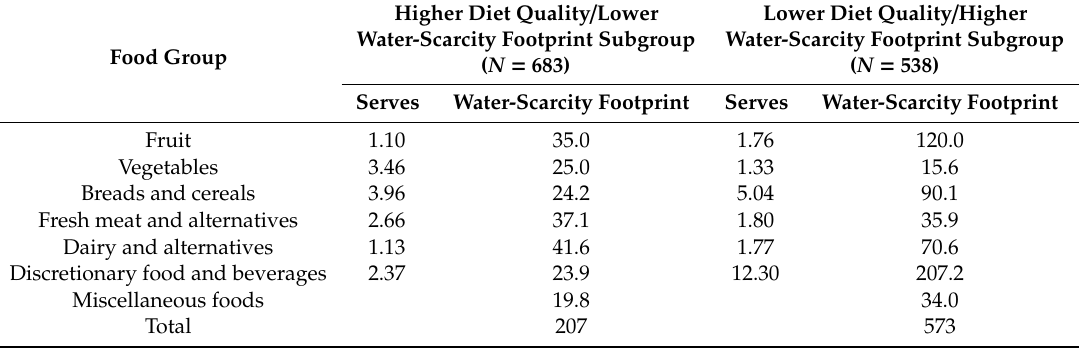
Table 2. Dietary intake (serves person − 1 day − 1 ) and water-scarcity footprint (L-eq person − 1 day − 1 ) of Australian adult (19–50 years) daily diets.